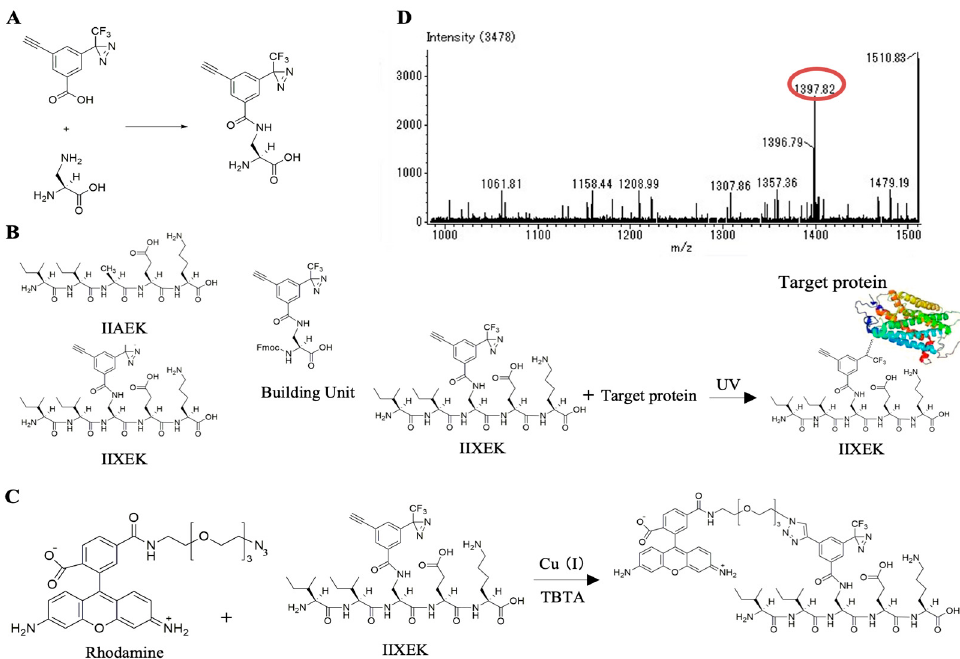
Figure 2. Chemical synthesis of the molecular probe, IIXEK. ( A ) Amide bond by 3-ethynyl- 5-[3-(trifluoromethyl)-3H-diazirin-3-yl] benzoic acid and (S)-2,3-diaminopropionic acid. ( B ) Structure of IIXEK. IIXEK possesses chemically synthesized 3-ethynyl-5-[3-(trifluoromethyl)-3H-diazirin-3-yl] benzoic acid. This probe captures the target proteins interacting with IIAEK. ( C ) Click reaction, which occurs by introduction of rhodamine into IIXEK in the presence of copper as catalyst (Huisgen cycloaddition reaction). ( D ) Mass spectrometry of Cu-Catalyzed Azide (Azide-fluor 488) Alkyne (IIXEK)